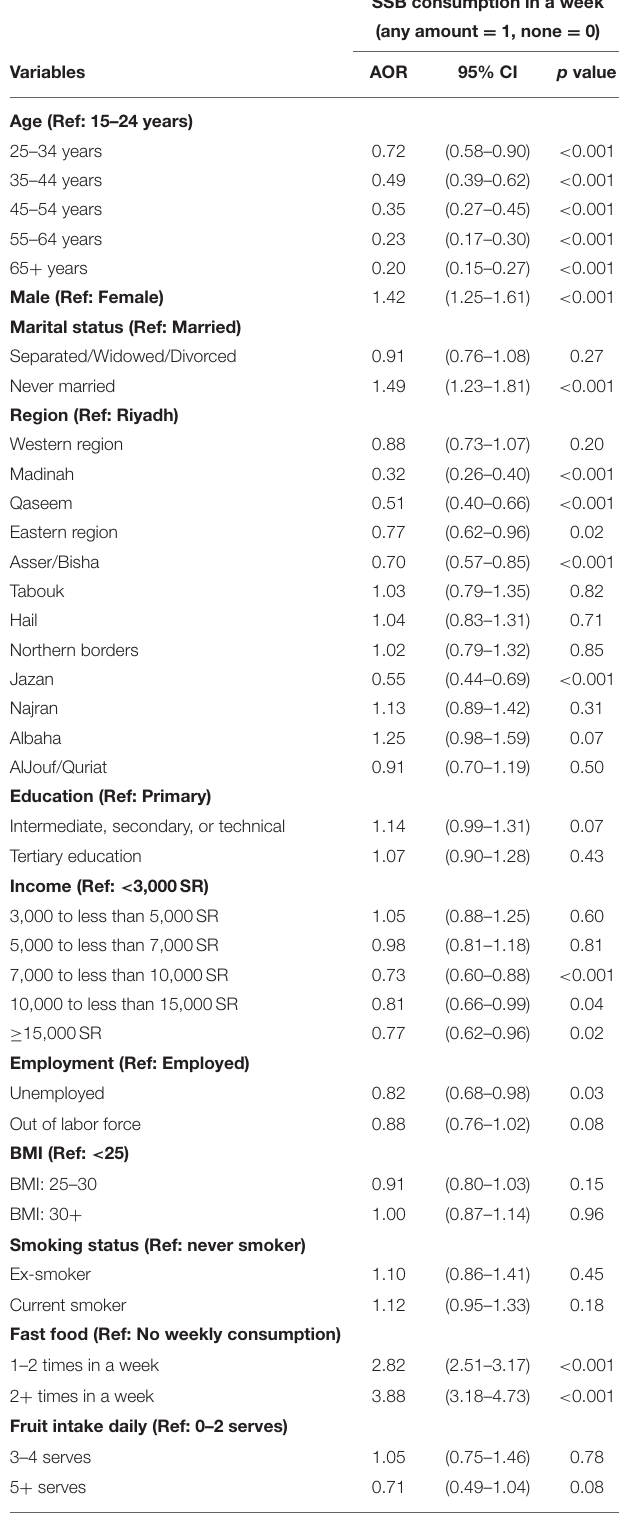
TABLE 3 | Association of weekly sugar-sweetened beverages (SSBs) consumption and study